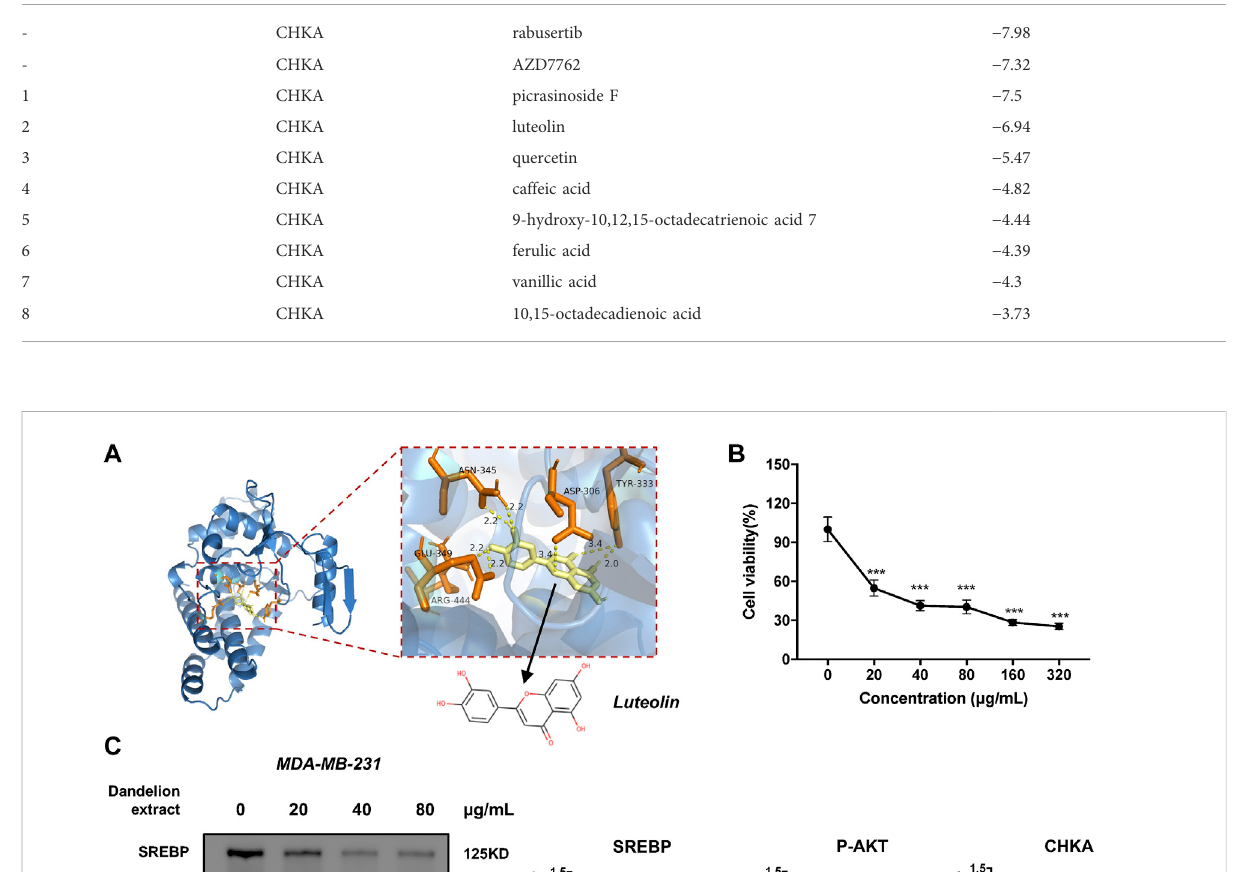
TABLE 2 The binding scores between CHKA andthe compounds from dandelion extract. Ranking